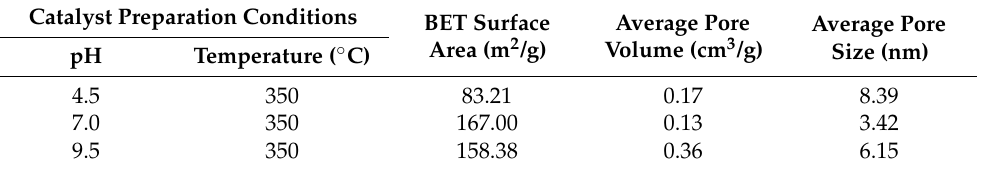
Table 2. Pore properties of MoS 2